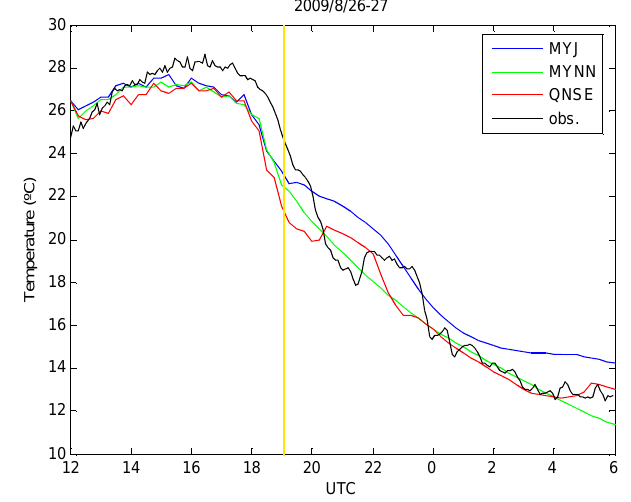
Figure 6. Simulated and observed (5-min averaged) friction veloc- ity for 28–29 August transition (type